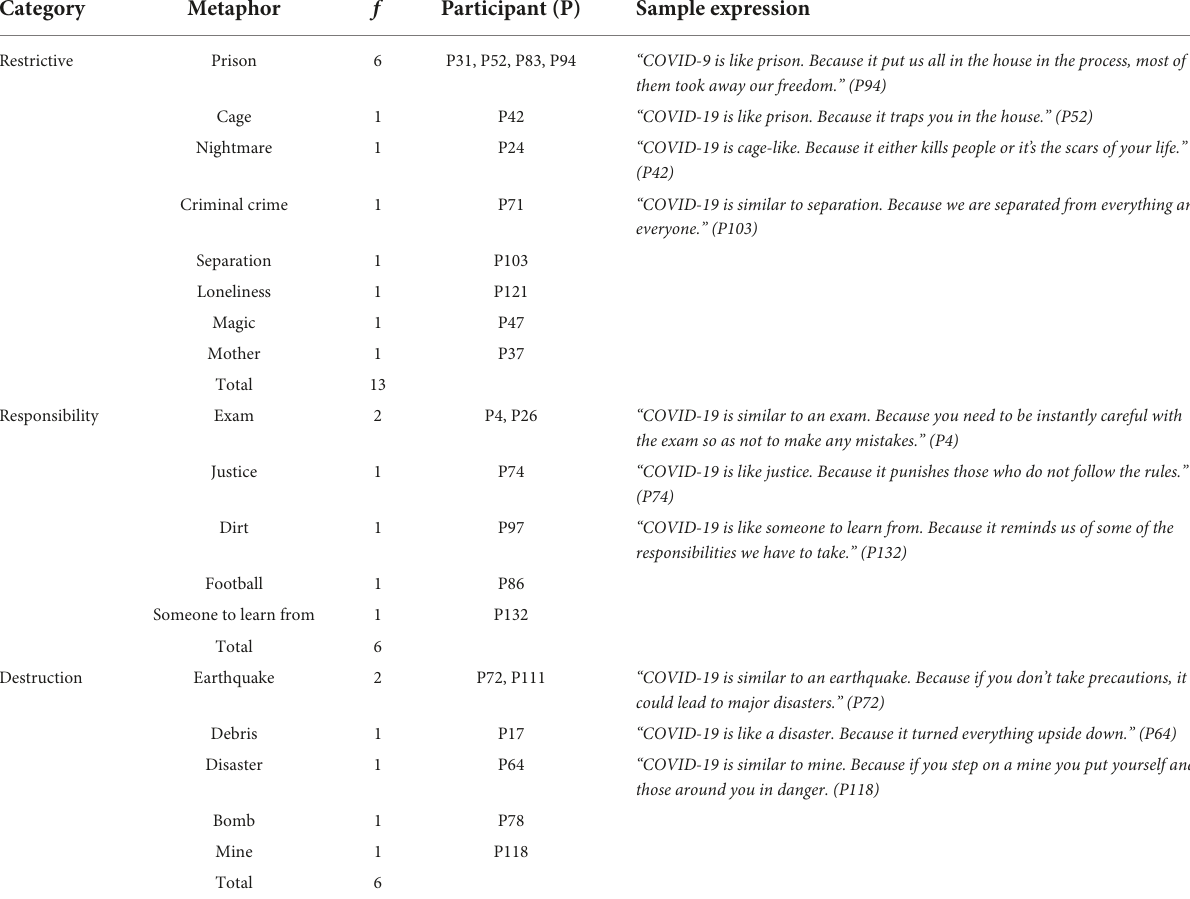
TABLE 9 Restrictive category, responsibility category, and destruction